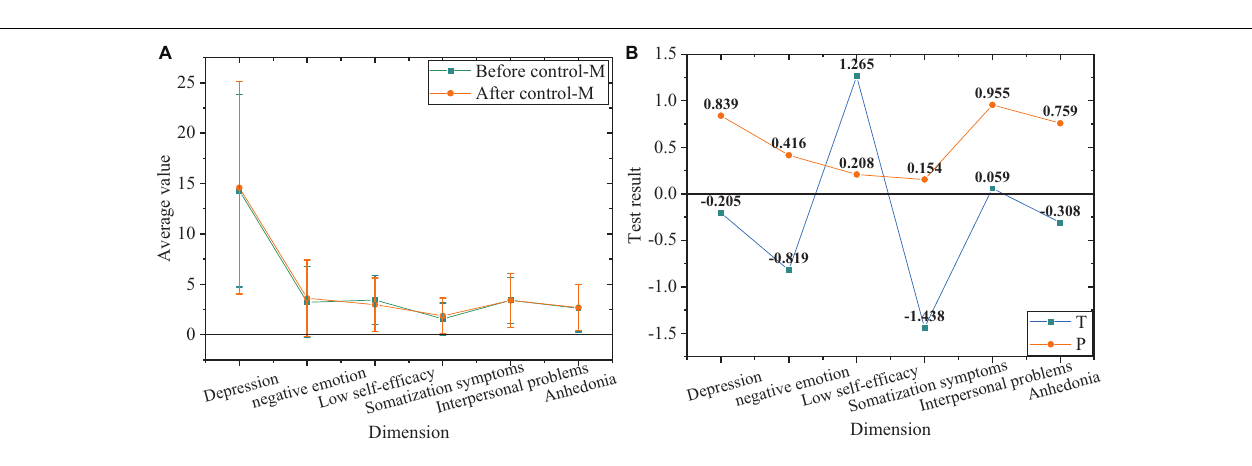
FIGURE 8 | Comparison of negative emotions. (A) The control group before and after the experiment. (B) Value of T and P of the control group before and after the